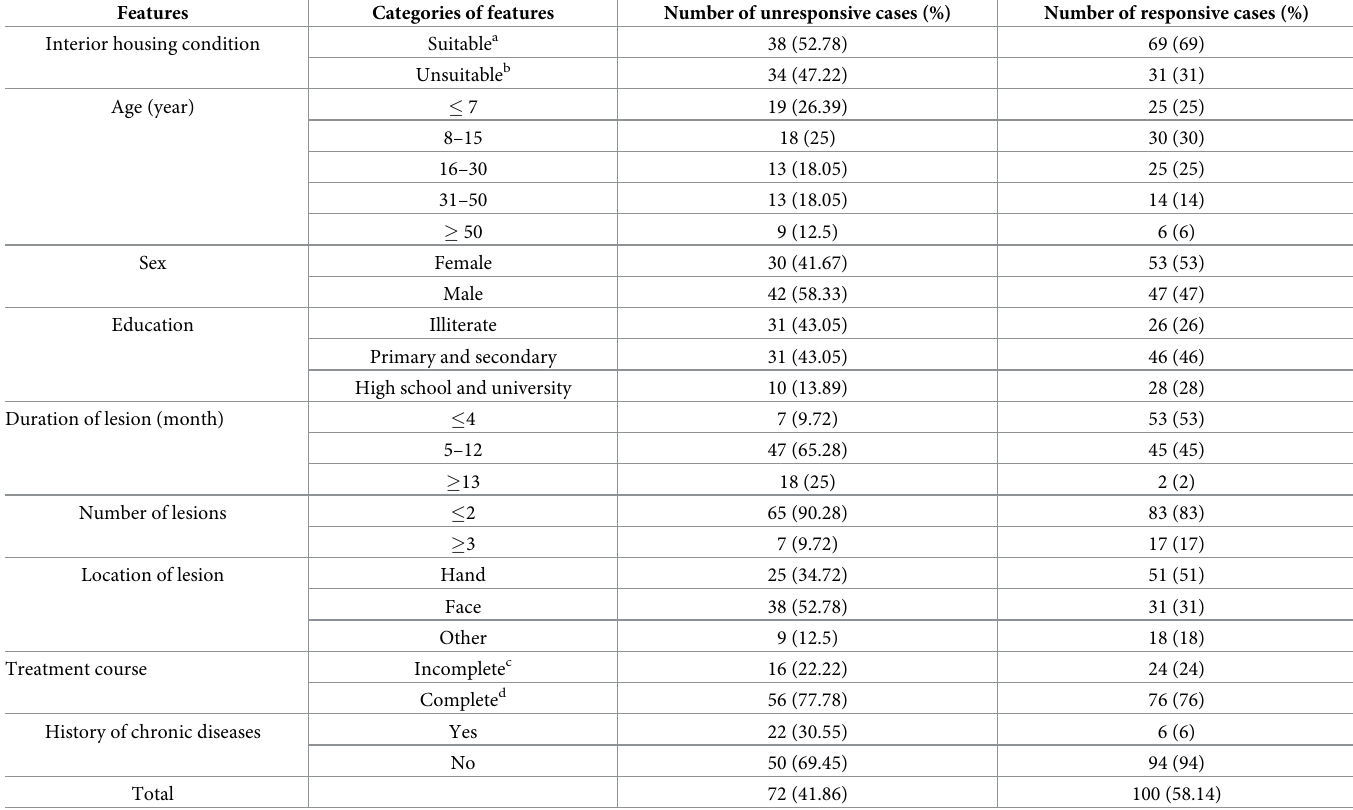
Table 1. Baseline features of unresponsive and responsive patients with anthroponotic cutaneous leishmaniasis.